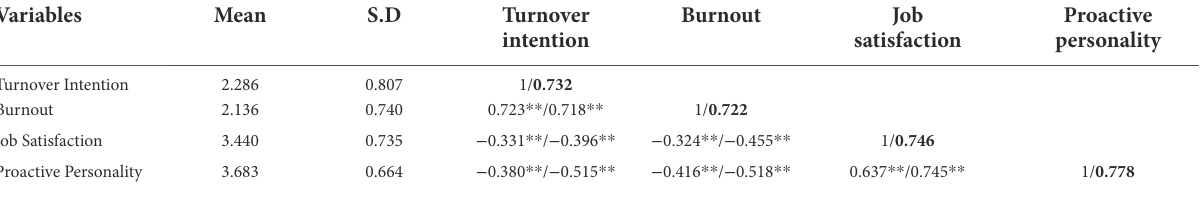
TABLE 4 Descriptive statistics, square root of the AVE, and correlation analysis among